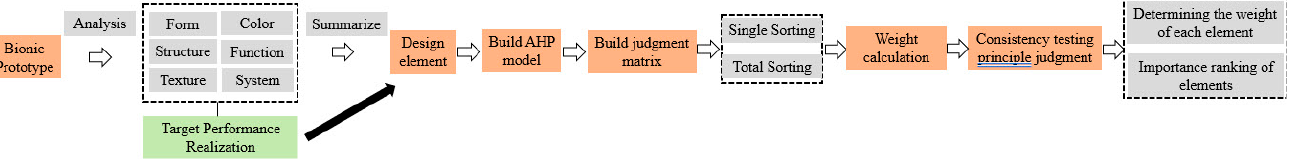
Figure 8. AHP method suitable to bionics.